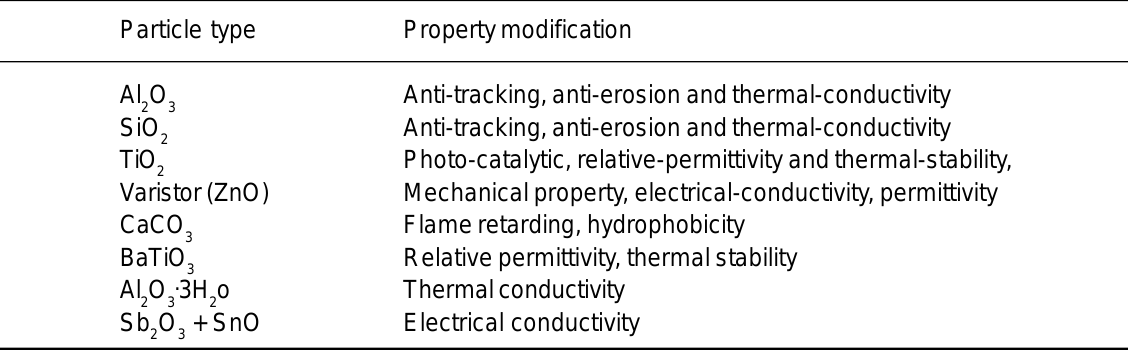
Table 1. In-organic fillers and their role in